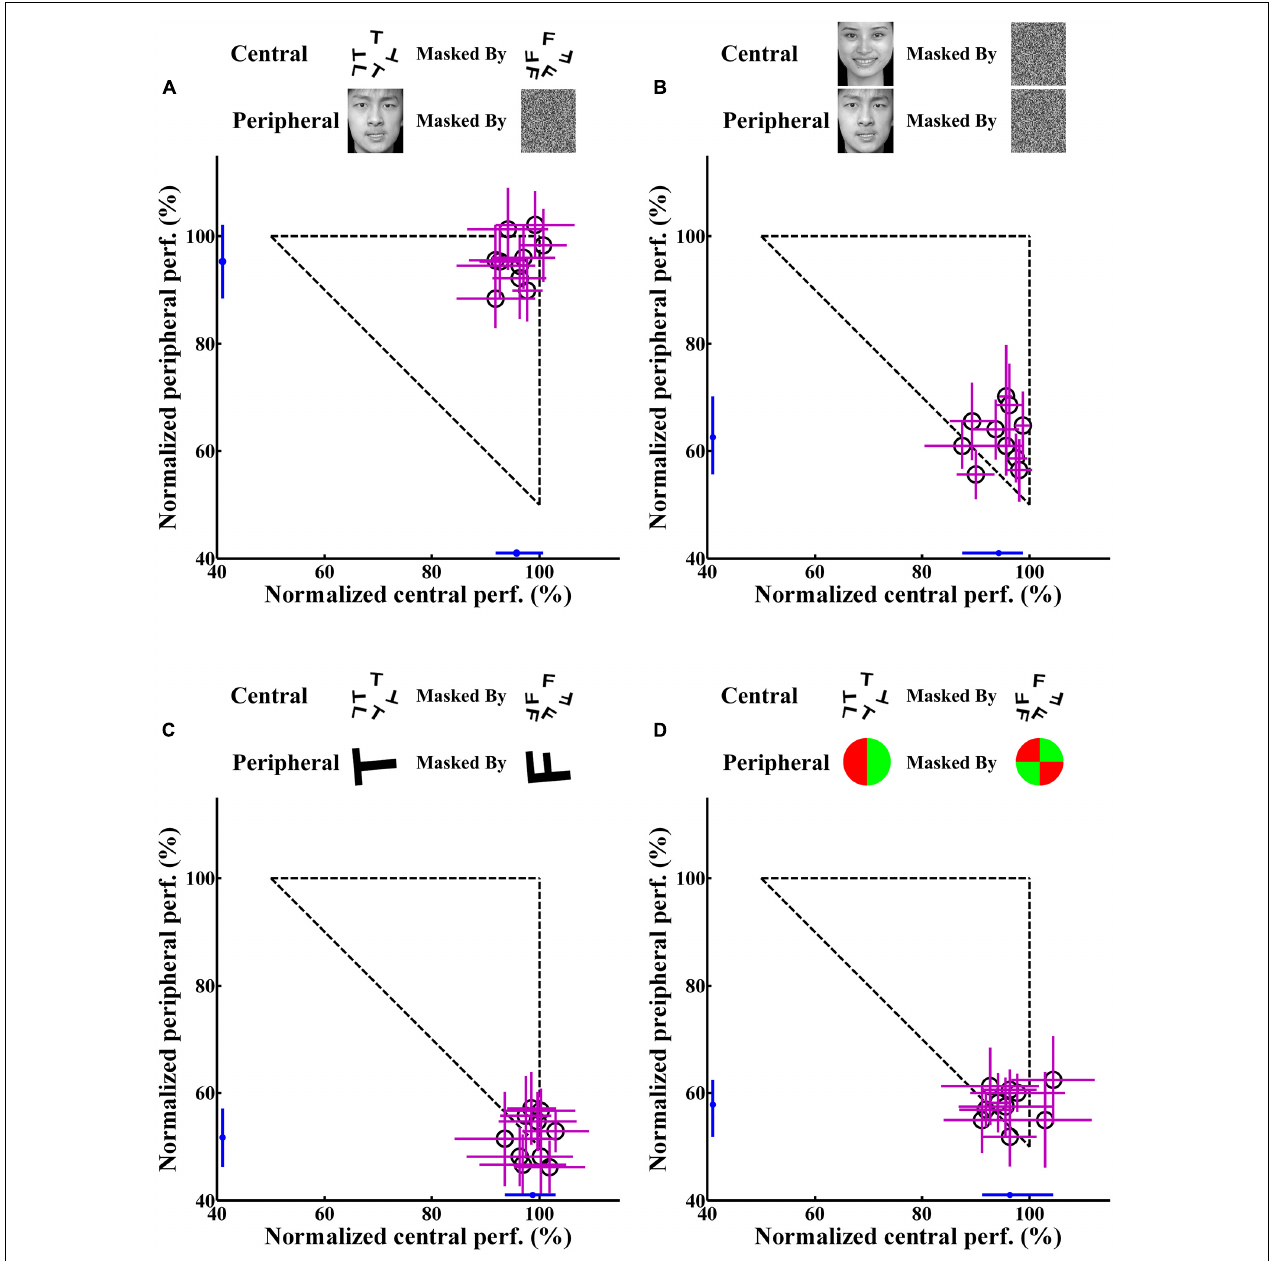
FIGURE 4 | Individual and average central and peripheral performances under the dual-task condition in the four experiments. The horizontal axis represents the performance of the attention-demanding central task. The vertical axis represents the performance of the peripheral task. Each open circle represents the individual performance of one subject in the dual-task, and the small blue dot near the horizontal or vertical axis represents the average performance of corresponding central or peripheral task for all subjects. The accuracy rate is the normalized data. Error bars represent SD. (A) Central letter-peripheral emotional face discrimination task. (B) Central – peripheral emotional faces discrimination task. (C) Central – peripheral letter discrimination task. (D) Central letter – peripheral color disk discrimination